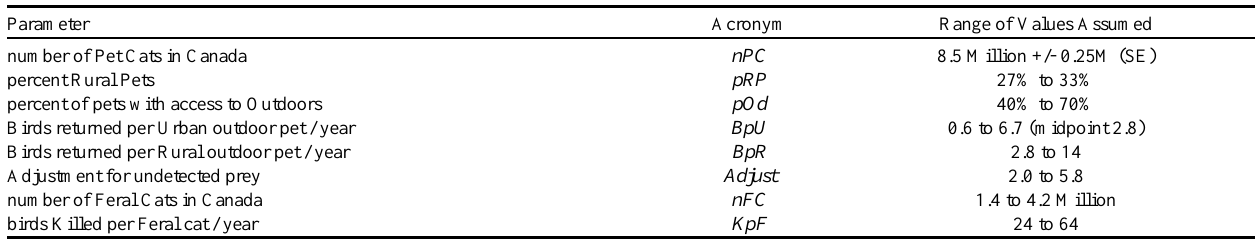
Table 1 . Parameters and ranges of values used in calculations to estimate bird kills in Canada. Acronyms used in formulae are listed for each